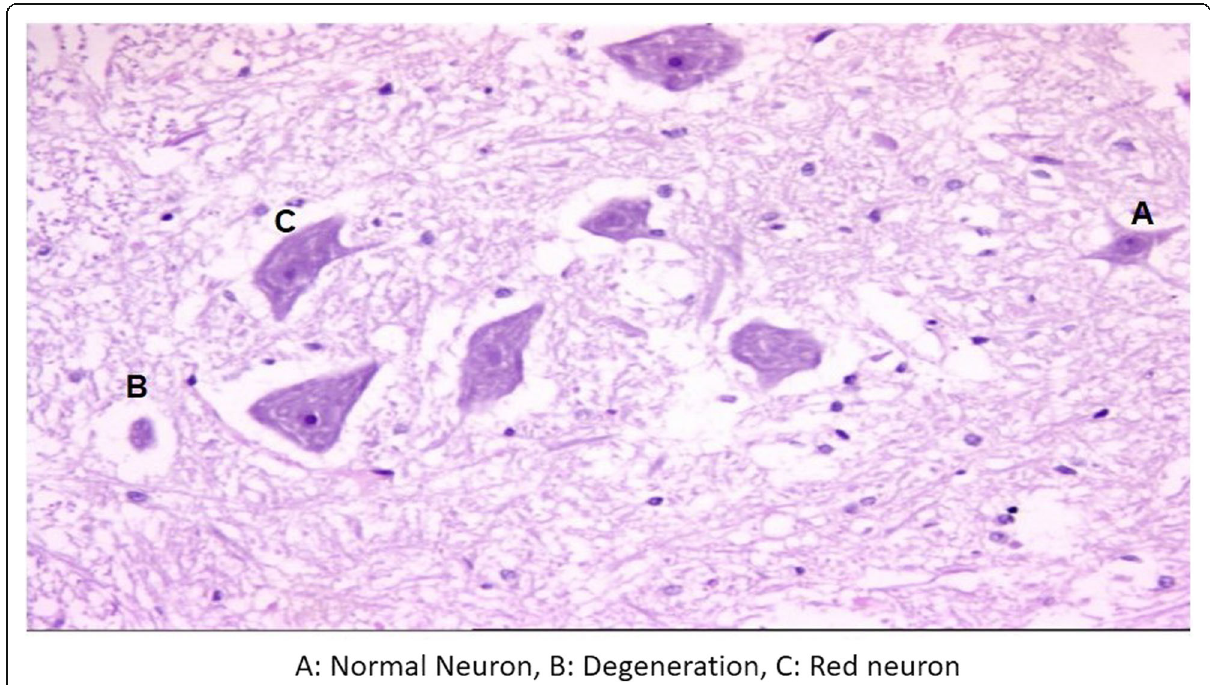
Fig. 3 The histopathology of the spinal cord section of a rat (hematoxylin- and eosin-stained section, × 200)